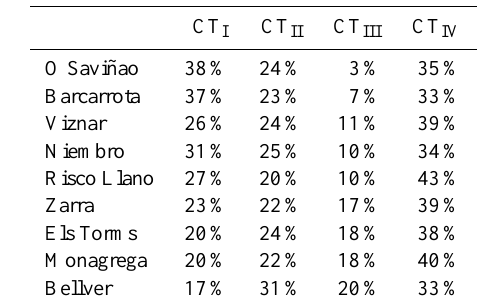
Table 5. Impact index calculated for each sampling site during each CT leading to ADO over the western Mediterranean Basin in the period